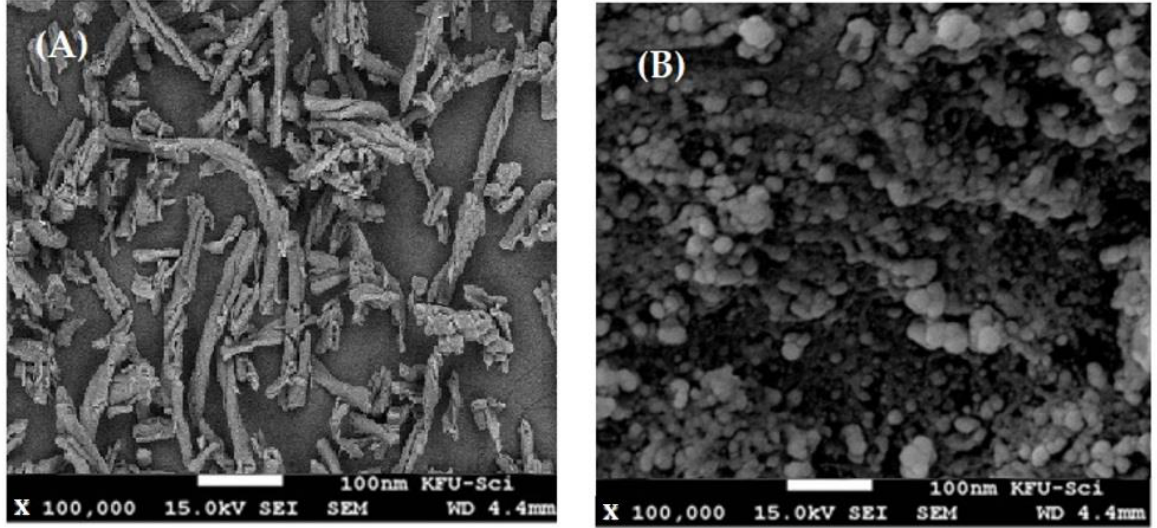
Figure 3. SEM of ( A ) Zn@BTC and ( B ) CMC/Zn@BTC.